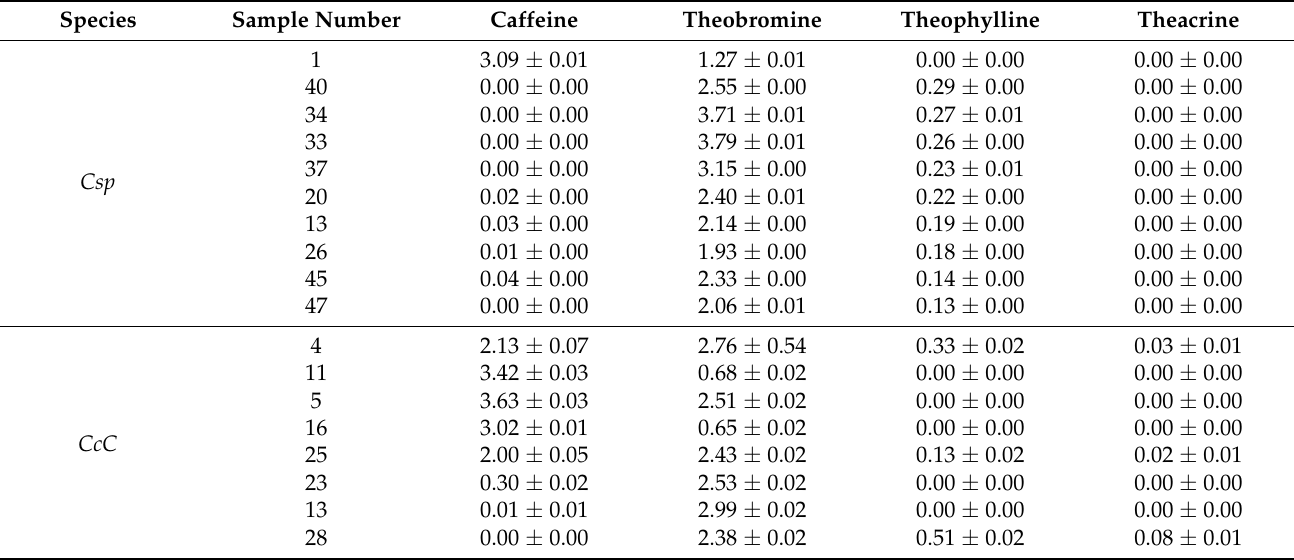
Table 3. Variation and distribution of purine alkaloids in three Camellia species. Table 5. Some special germplasms of three Camellia